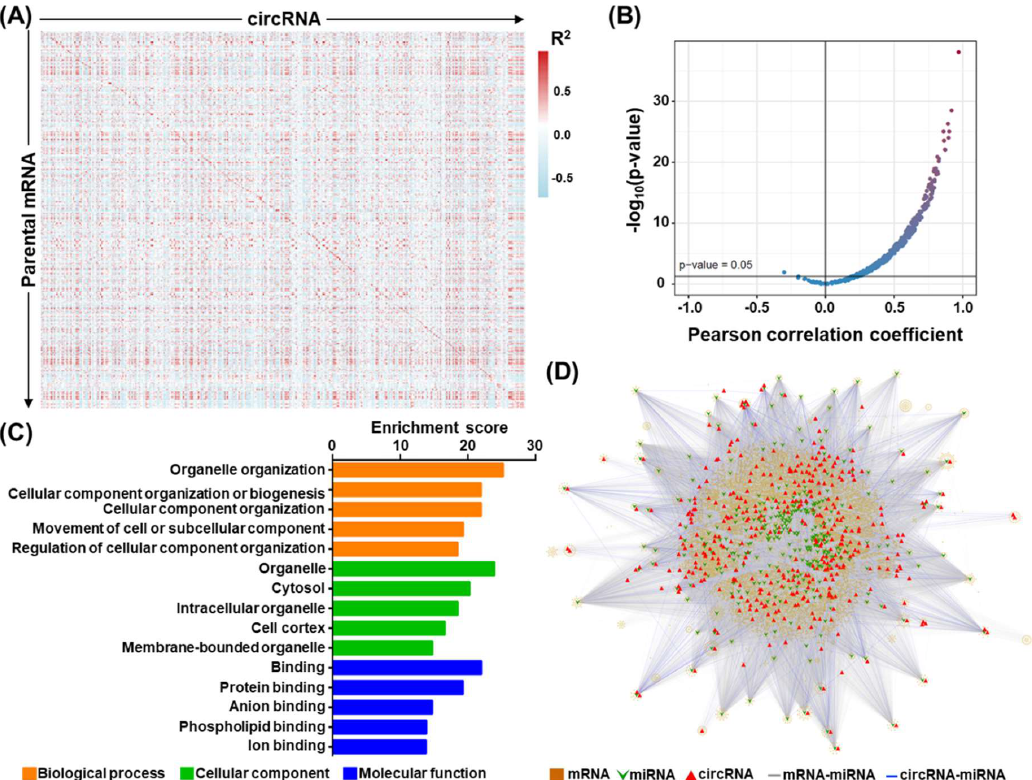
Figure 2. Transcriptomic networks in association with circRNAs in OSCC. ( A ) Gene co-expression analysis was performed between differentiated expressed circRNAs (horizontal axis) and their parental mRNA genes (vertical axis), based on the expression levels shown by OSCC RNA-seq data. The co-expression map is depicted as a heatmap, in which the correlation coefficients are represented by the colors shown by the scale bar in the right panel. ( B ) Extent of coordinated expression for circRNA and host mRNA pairs presented as a volcano / scatter plot, according to each pair’s correlation coe ffi cient (x-axis) and significance ( p -value; y-axis). ( C ) Gene ontology (GO) enrichment analysis of DEC-encoding host genes was performed. The x-axis indicates the significance of enrichment for the indicated term. ( D ) Construction of the circRNA–miRNA–mRNA regulatory network in OSCC. The miRNA interactions were predicted for each circRNA–mRNA pair with correlated expression in the OSCC specimens (padj < 0.05, cor > 0). A three-tier, ceRNA connection was established if an miRNA-targeted sequence was commonly found in the mRNA–circRNA pair (i.e., with a least two hits in circRNA). mRNA, squares; miRNA, inverted triangles; circRNA, triangles; miRNA–mRNA interaction, gray line; circRNA–miRNA interaction, blue